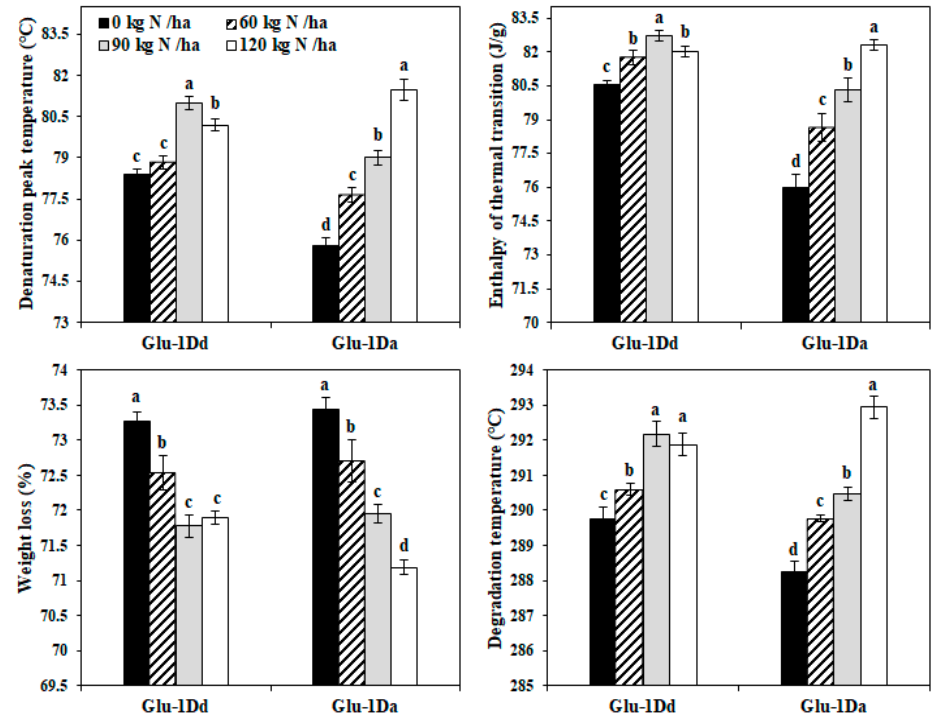
Figure 5. Thermal properties obtained from the gluten containing Glu-1Dd and Glu-1Da under di ff erent application N rates. The same letter in the di ff erent columns for each material indicates no significant di ff erence ( p > 0.05). Data are presented as the mean of two years.